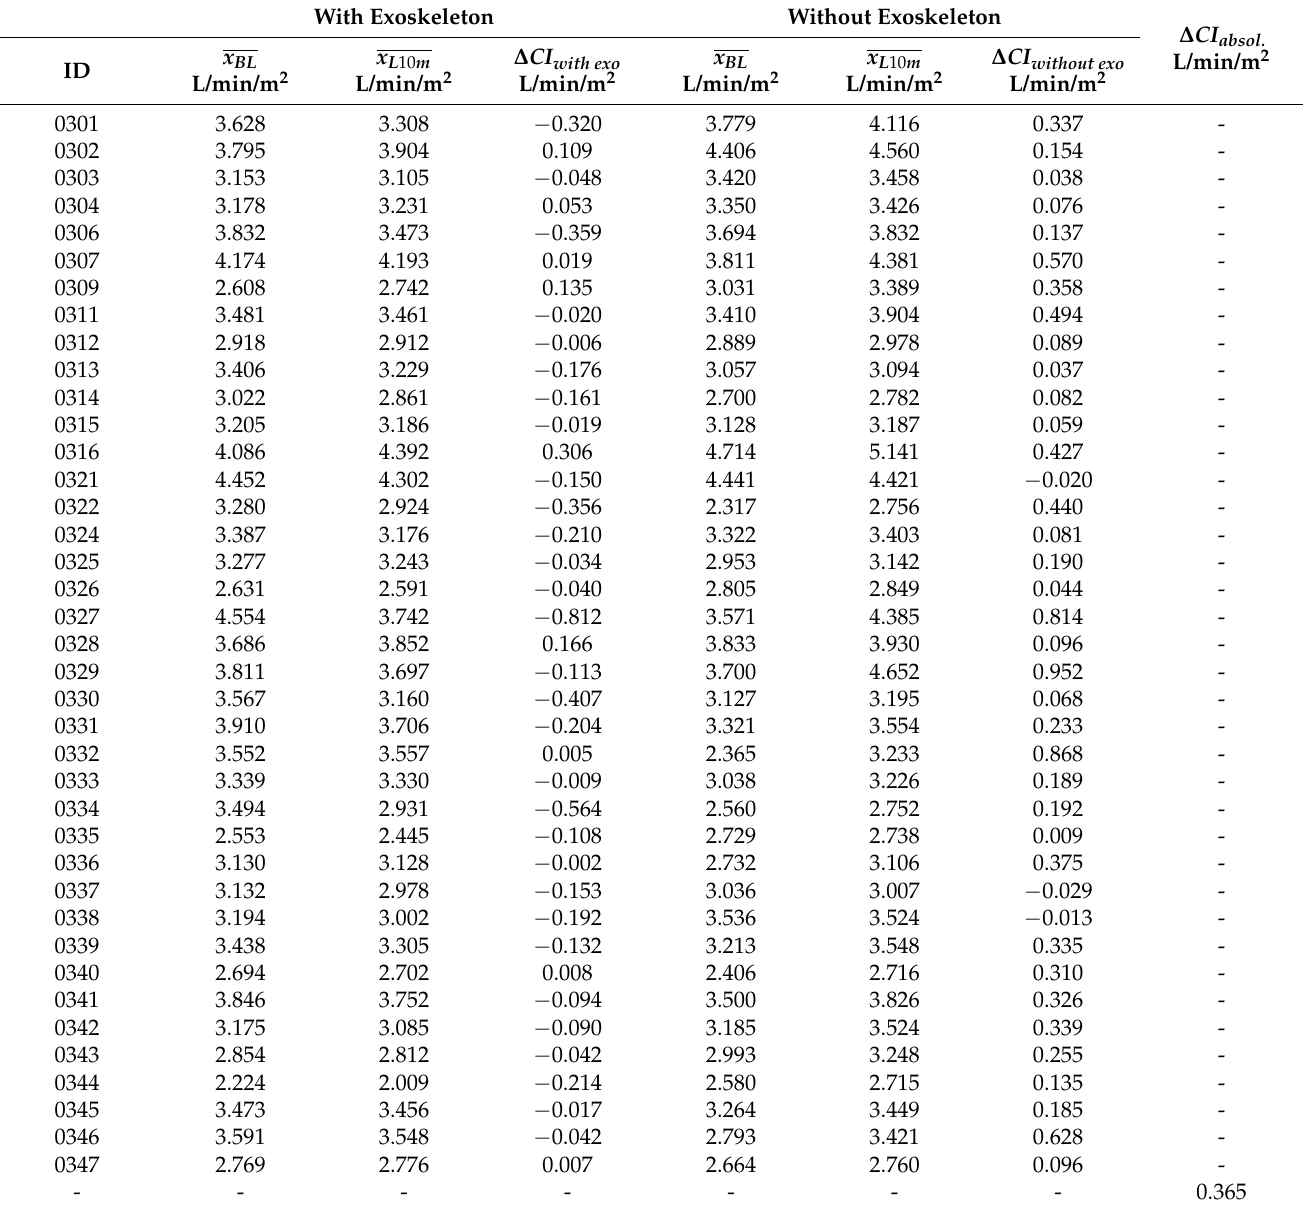
Table A1. Averaged CI at baseline x BL , last ten minutes x L 10 m and difference ∆ CI with and without exoskeleton for all subjects. With Exoskeleton Without Exoskeleton